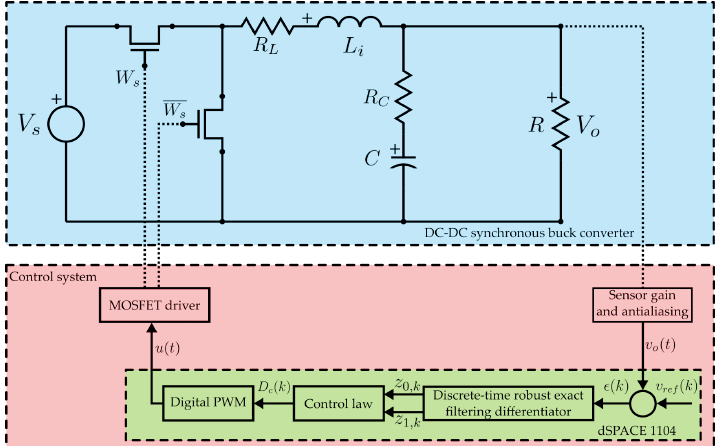
Figure 2. Block diagram representation of the system to evaluate the proposed control for the DC-DC buck converter.